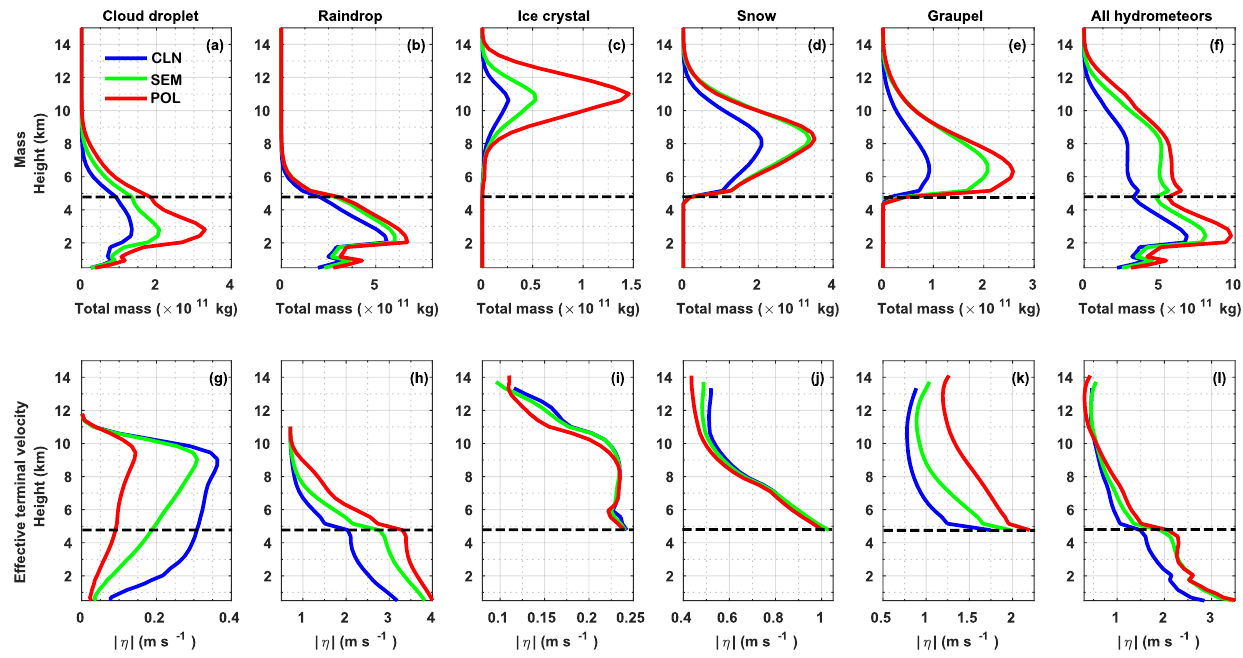
Figure 6. Vertical profile of (a–f) total mass over the domain (kg) and (g–l) mean effective terminal velocity ( η ; ms − 1 ) over cloudy regions during 4–12h of the simulation for cloud droplet (first column), raindrop (second column), ice crystal (third column), snow (fourth column), graupel (fifth column), and all hydrometeors (sixth column). The dashed black lines denote the ZTL ( ∼ 4.8km).